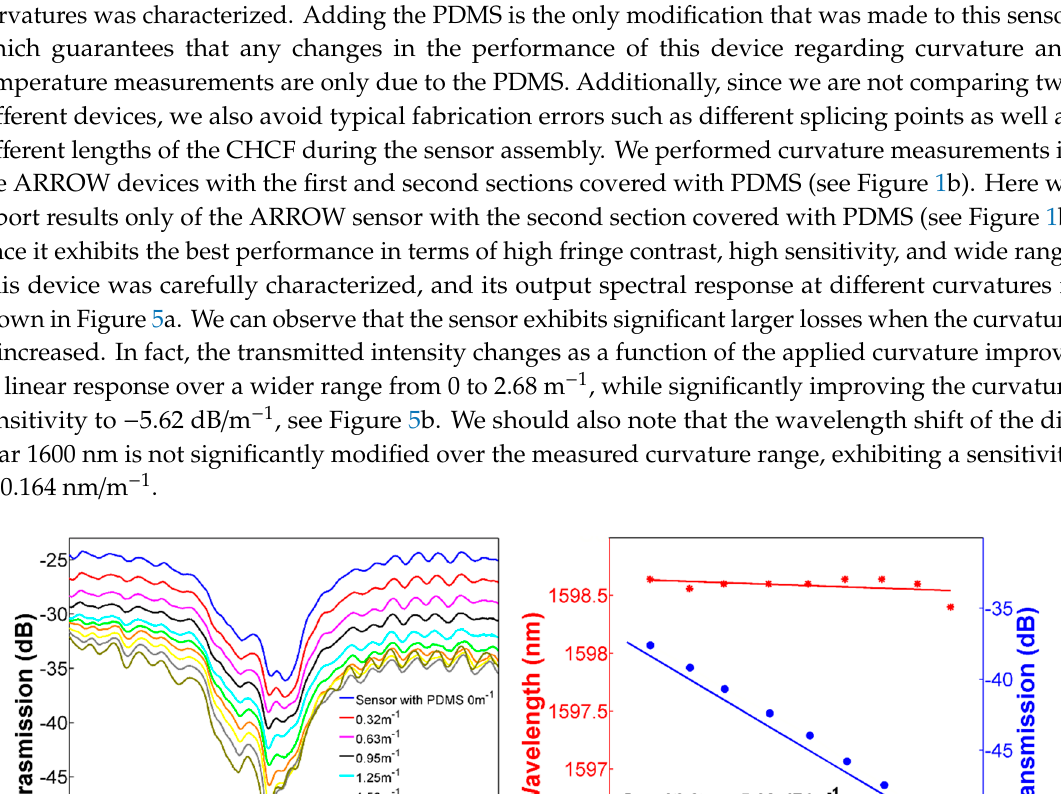
Figure 4. ARROW sensor without PDMS ( a ) Spectral response of the sensor for curvatures from 0 to 2.68 m − 1 ; ( b ) Dip wavelength shift and transmitted intensity changes as a function of the applied curvature.